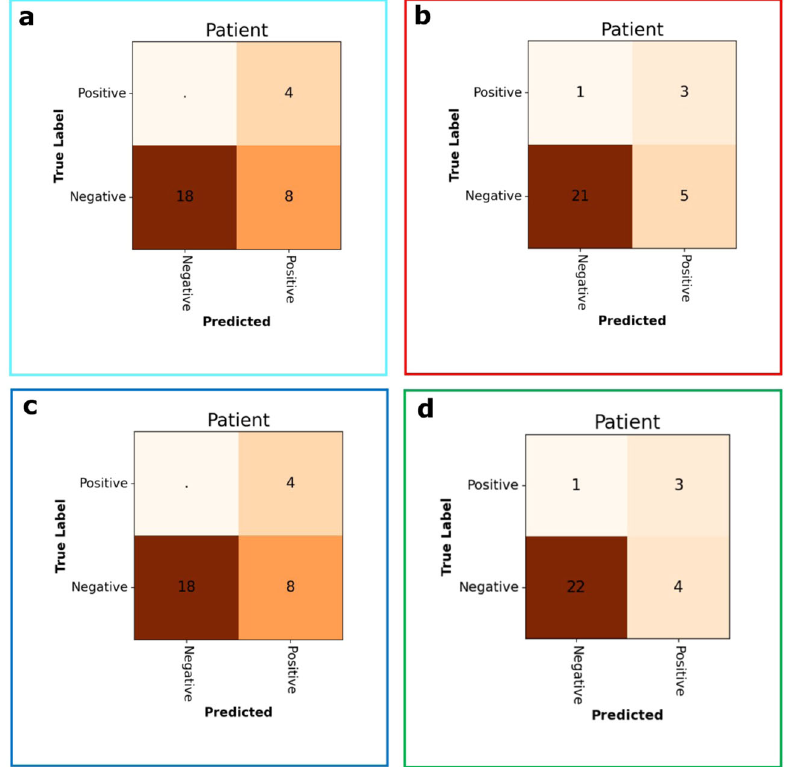
Fig. 5 Confusion matrices for EVS2 for each fold. Frame colours correspond to cross-validation folds ( a – d ) from Figs. 3 and 4. Vessel status is extracted automatically from all 30 patients in EVS2. Note that this experiment comprises of four DVT positive and 26 DVT negative patients, thus sensitivity/true positive rate is discretised in a ROC curve with only four steps, which makes a plot less